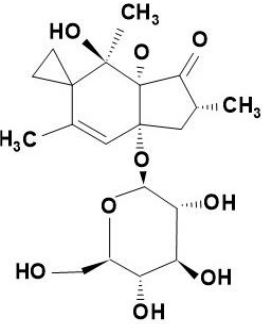
Figure 2. The chemical structure of the ptaquiloside (PTA) molecule.